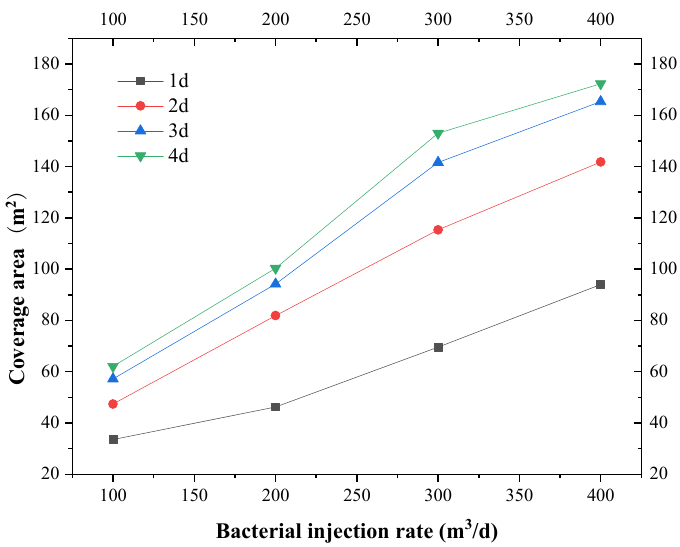
Figure 17. Variation curve of bacterial coverage area with injection rate.